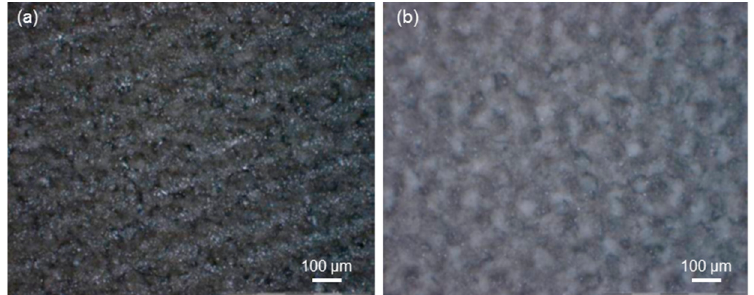
Figure 9. Optical micrographs showing the laser-treated surfaces of ( a ) sample 1c ( Δα = 20°, number of cycles = 1) and ( b ) sample 2c ( Δα = 20°, number of cycles = 5).